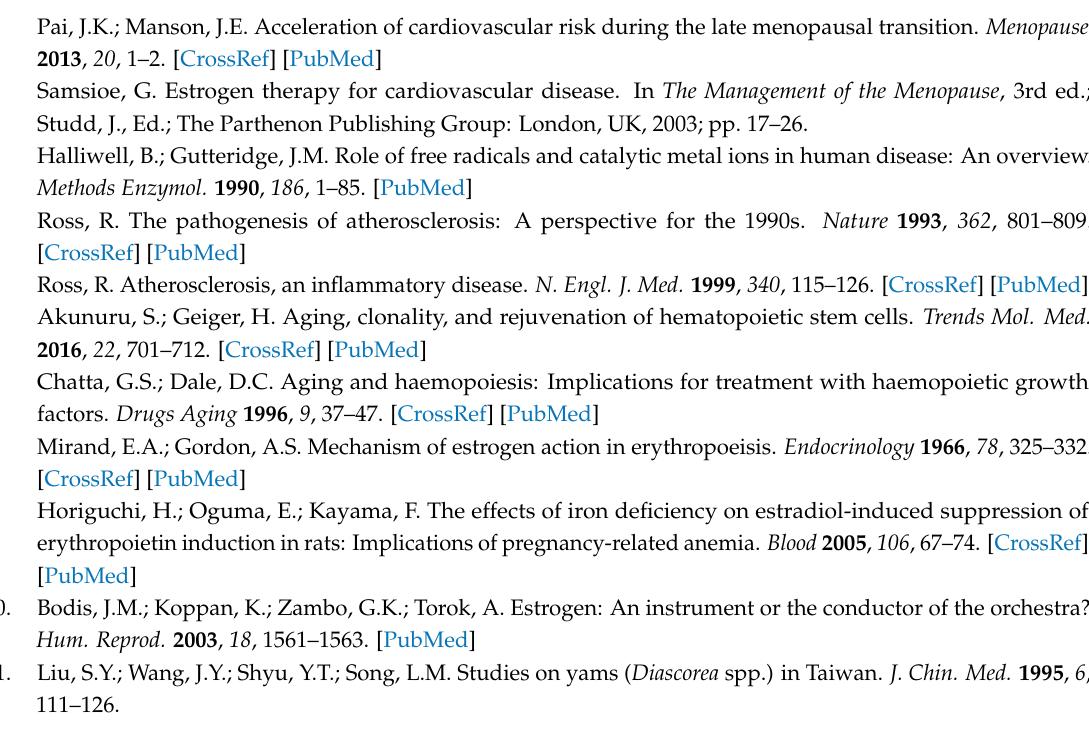
Figure S1: GC-MS chromatogram for extract of Diascorea alata and structural identifications and quantitative analyses of phytosterol derivatives are presented, Figure S2: Structural identification was confirmed by comparison of the retention times and mass spectra obtained for Diascorea alata (upper figure) and those of derivative sterol standards of β -sitosterol, γ -sitosterol, and 22-23-dihydro-stigmasterol, Figure S3: Flow chart for